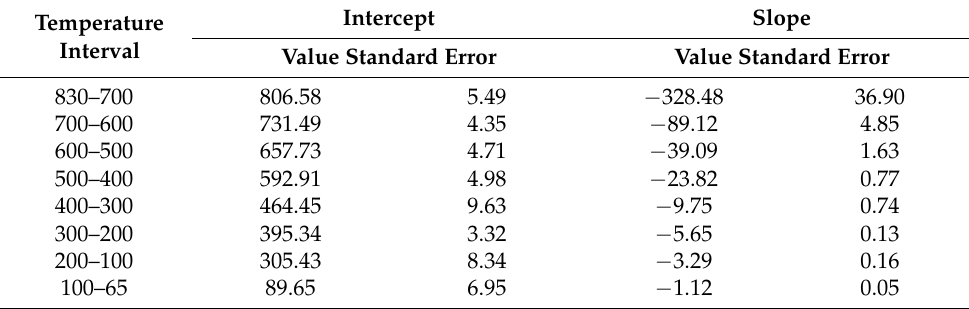
Table 4. Cooling rate of the node on the surface.